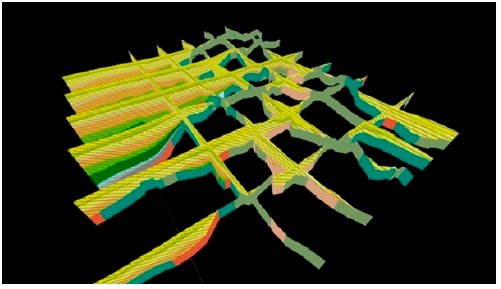
Figure 41. Geological section.